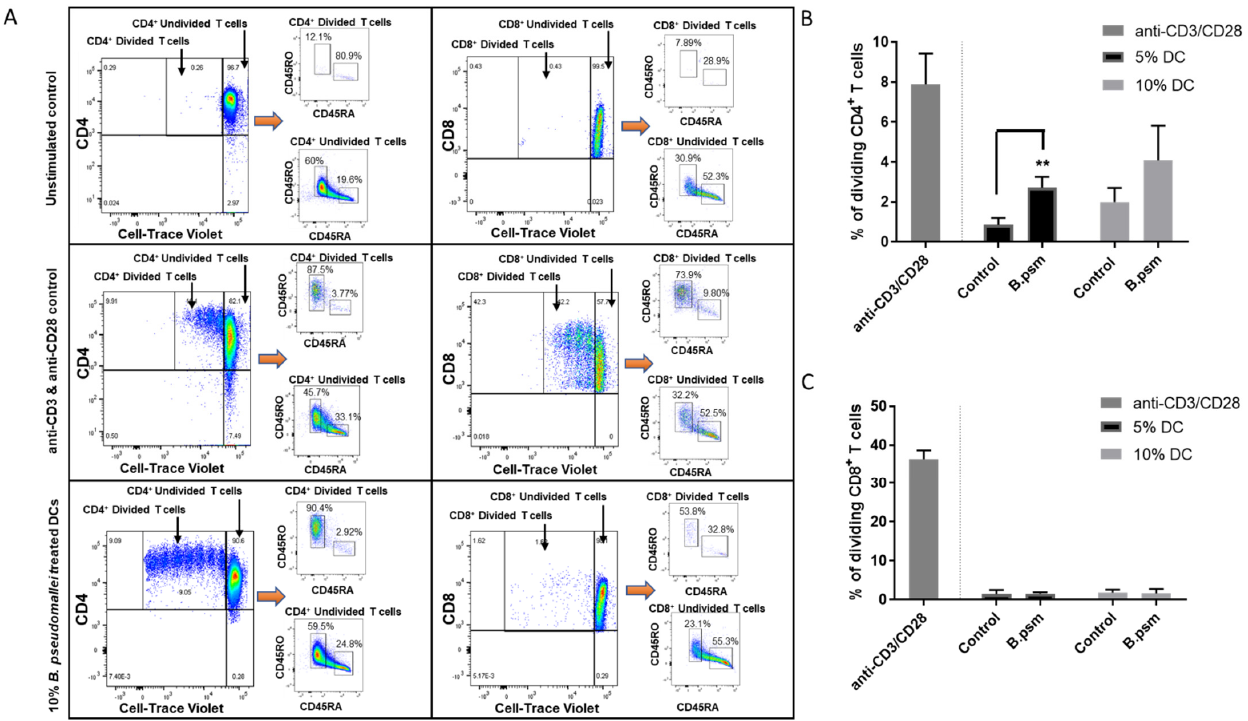
Figure 5. B. pseudomallei stimulates a primary CD4 + T helper cell response in healthy donors. Enriched DCs were stimulated for 20 h with B.psm or medium alone (control). 2.5 × 10 5 syngeneic total T cells were then co-cultured with either 5% or 10% stimulated DCs for 7 days. Anti-CD3 and anti-CD28 were used as a positive control for T-cell stimulation. ( A ) T cells subsequently acquired on the flow cytometer were divided from the total on the basis of low expression of CTV. These CD4+ CTV low or CD8+ CTV low were proliferated cells and selected for further analysis. Cell activation markers, CD45RA and CD45RO, were used to confirm naïve or activated/memory status, respectively, within the divided and undivided cells. Examples are given of unstimulated (top panels), positive stimulation with anti-CD3 and anti-CD28 (middle panels) or 10% DC-treated with B.psm (bottom panels) CD4 + and CD8 + T cells after 7-days culture. Expression of cell-surface markers CD45RO and CD45RA were used to define activation status of proliferated vs. non-proliferated T cells. Pooled data showing the % of proliferated ( B ) CD4 + or ( C ) CD8 + T cells after 7 days incubation with 5 or 10% of DCs stimulated with or without B.psm or with anti-CD3 and anti-CD28. Bars represent mean values ± SEM from three independent experiments. A Student’s paired t- test was used to compare the untreated control to B.psm group. ** p < 0.01.